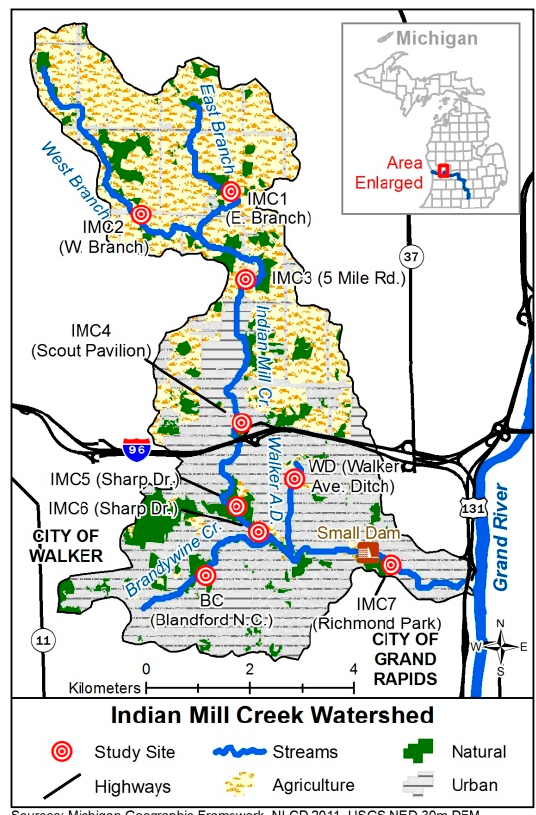
Figure 1. Study area map of the Indian Mill Creek watershed with features, land cover, and sites.